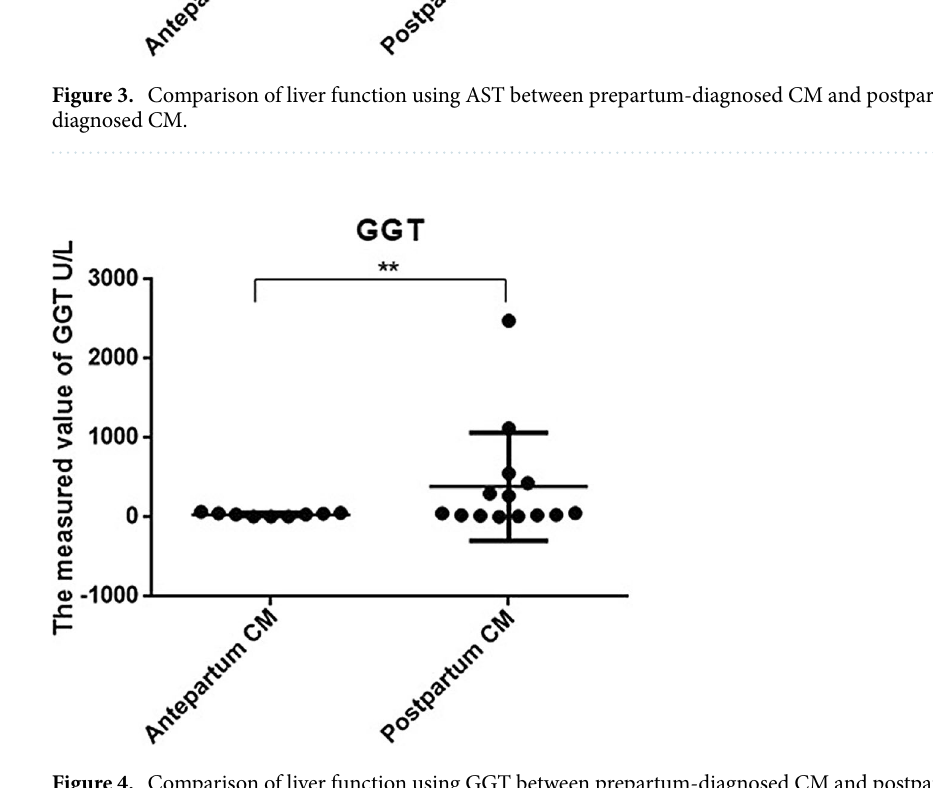
Figure 4. Comparison of liver function using GGT between prepartum-diagnosed CM and postpartum- diagnosed